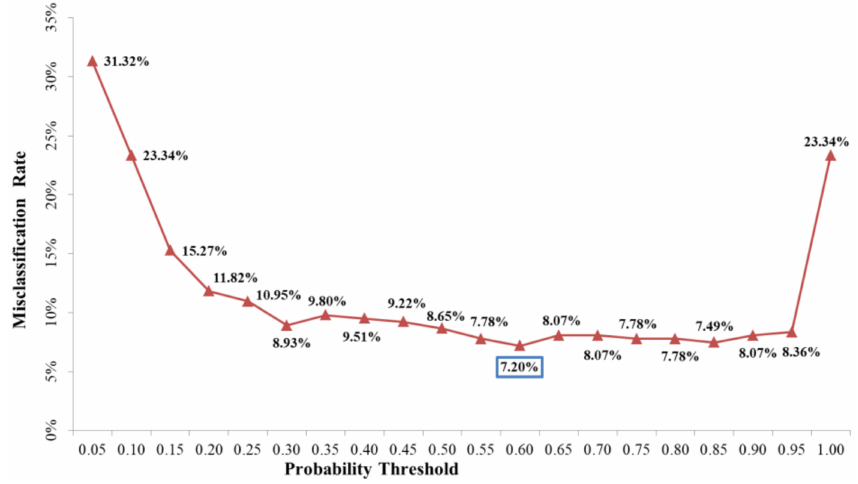
Figure 5. Misclassification rate vs the probability thresholds of composite heavy metal pollution risk.